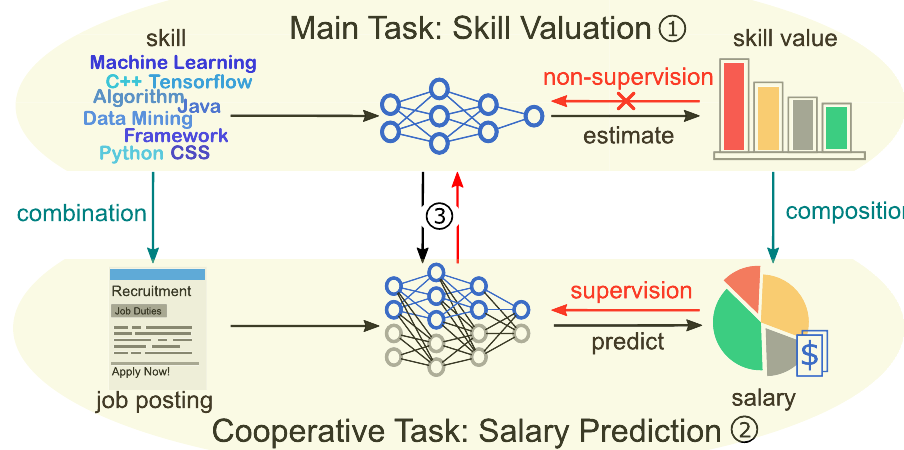
Fig. 1 A schematic diagram of the key idea in this study. (1) Our main task is to train a skill valuation model with machine learning technology. Under the paradigm of supervised learning, we need a set of training data with explicit labels of skill value to provide supervision for the model. Then the model can learn a function that maps the input (i.e., context and skills) to the observation (i.e., skill value). However, the labeled data of skill value is unavailable in our dataset. (2) We have abundant data of job postings with labels of salary, which can provide supervision for training a salary prediction model. Therefore, with the intuition that valuable skills should lead to high job salary, we regard salary prediction as a cooperative task that provides indirect supervision for skill valuation model. (3) We propose a model, SSCN, to simultaneously achieve skill valuation and salary prediction tasks, where the skill valuation model is a component of the salary prediction model. Speci fi cally, SSCN estimates the skill value and composes skill value into job salary. In this way, the skill valuation model can be trained with feedbacks from the salary prediction